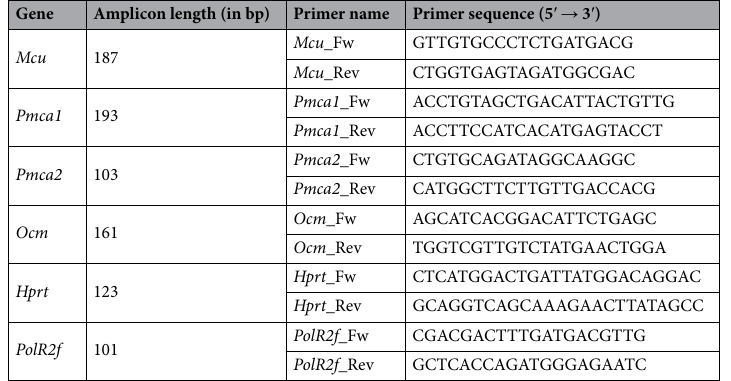
Table 1. Details of qPCR-primers. Mcu mitochondrial calcium uniporter, Pmca plasma membrane calcium ATPase, Ocm oncomodulin, Hprt hypoxanthine phosphoribosyltransferase, PolR2f polymerase (RNA) II (DNA directed) polypeptide F, Fw forward primer, Rev reverse